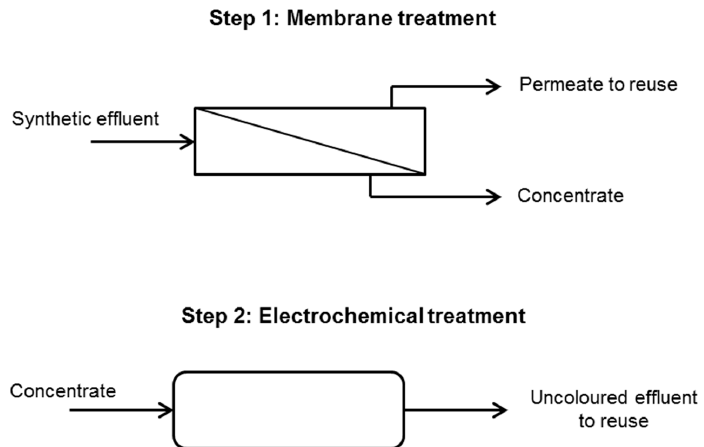
Figure 3. Combination of the nanofiltration and electrochemical process scheme.